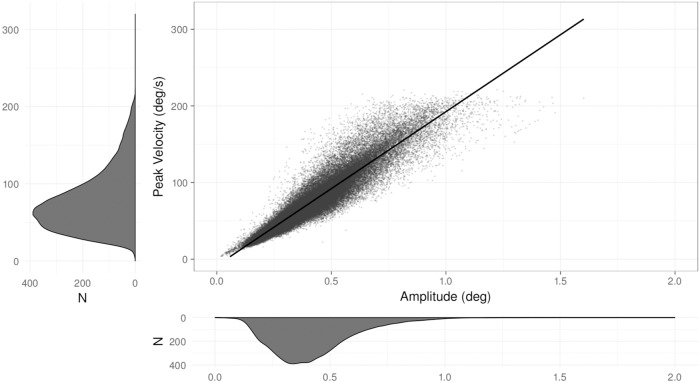
Microsaccadic peak velocity vs. magnitude (main sequence).Main panel: the scatter plot represents detected microsaccades with amplitude indicated on the abscissa and peak velocity on the ordinate. The line drawn through is a linear fit through the scatter plot. Bottom and side panels: microsaccade amplitude and peak velocity distributions (N = 13 subjects).